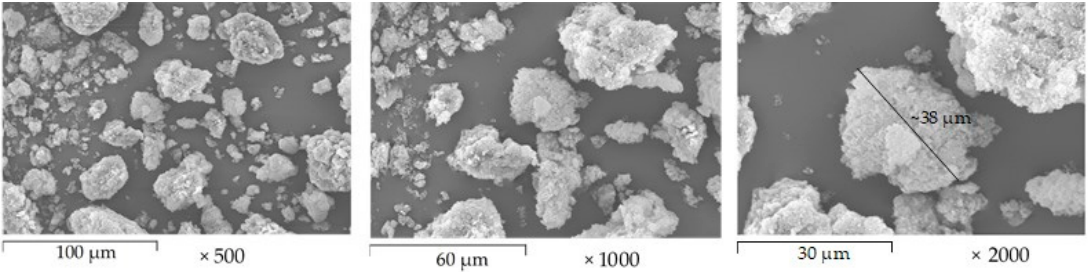
Figure 5. SEM micrographs of AX powder extracted from DDGS. Images at 500, 1000 and 2000 × magnification.